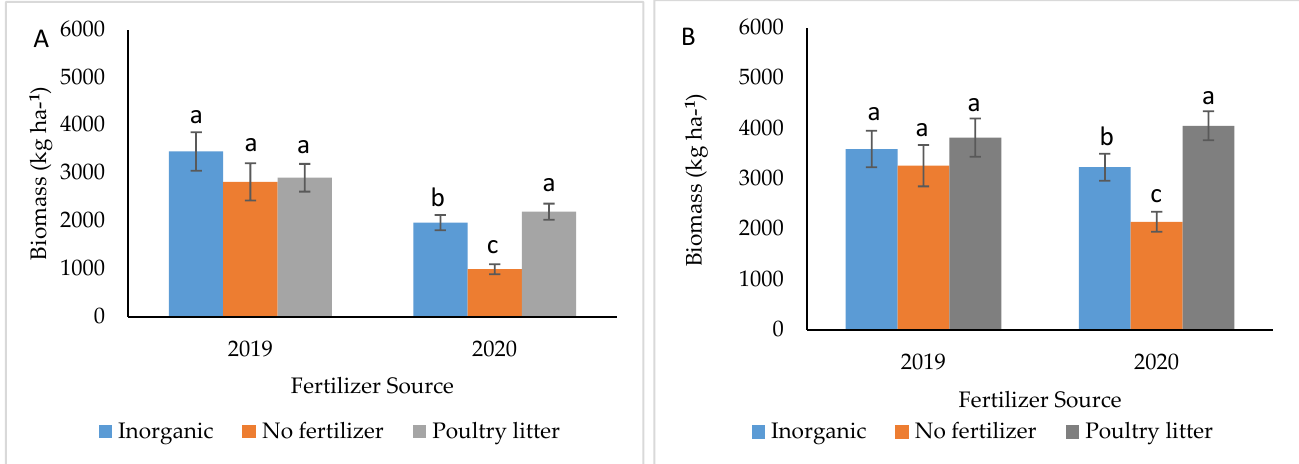
Figure 1. Fertilizer source effect on cover crop production in 2019 and 2020: ( A ) in early-terminated cover crop; ( B ) in late-terminated cover crop. Different letters indicate significant differences at p ≤ 0.05.